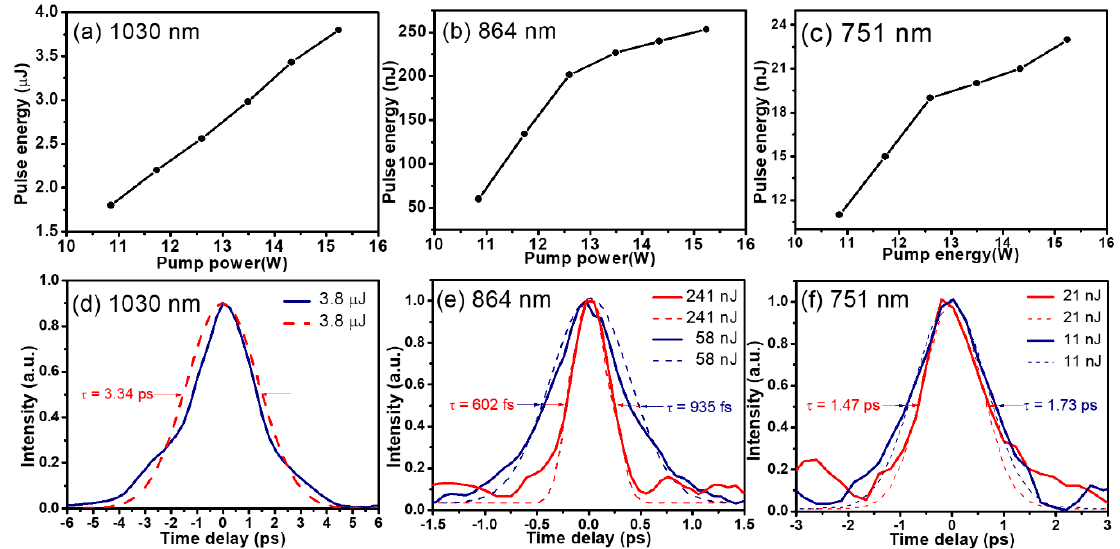
Figure 4. The evolution of the output pulse energy with increased pump power for the fundamental wave at 1030 nm ( a ), and anti-Stokes lines at 864 nm ( b ) and 751 nm ( c ). The measured autocorrelation trace for the fundamental wave at 1030 nm ( d ), and anti-Stokes lines at 864 nm ( e ) and 751 nm ( f ). The fundamental wave and anti-Stokes lines were selected by bandpass filters. In Figure 4d–f, the solid curves resulted from experimental measurements, while the dashed curves were via hyperbolic secant fitting.